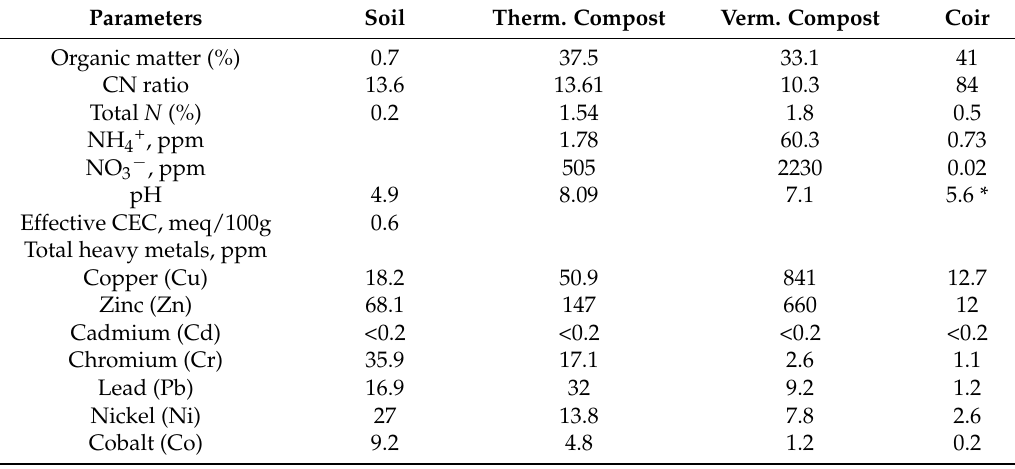
Table 2. Chemical properties of the soil, composts (thermophilic and vermicompost), and coir. Parameters Soil Therm. Compost Verm. Compost Coir Organic matter (%) 0.7 37.5